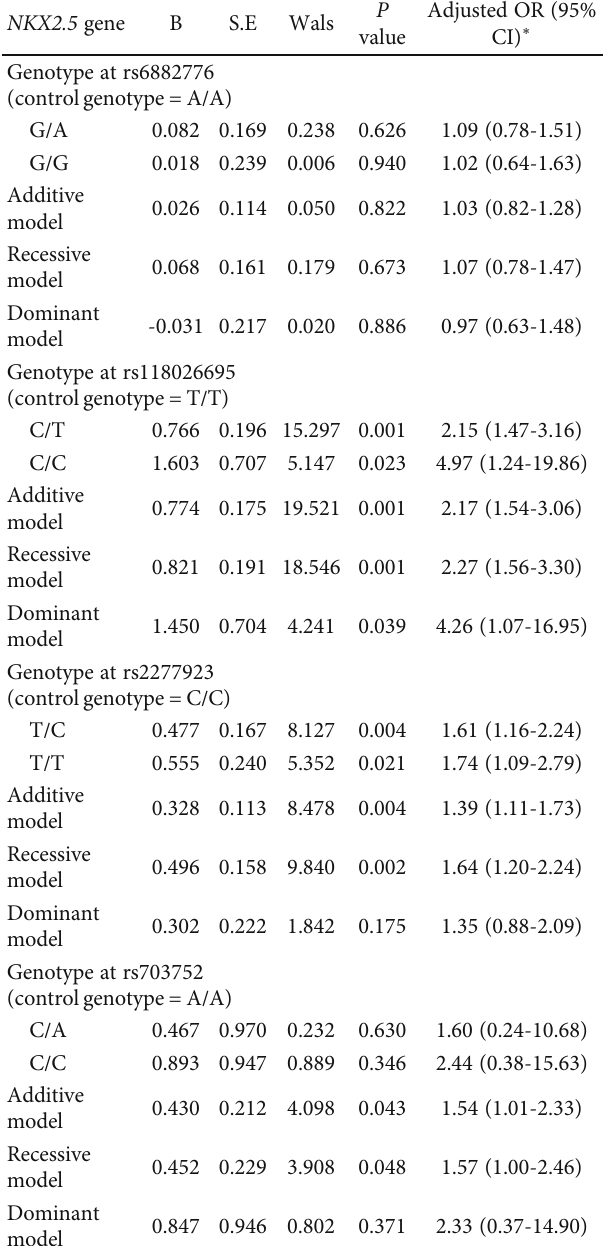
Table 5: Multivariate analysis of NKX2.5 gene polymorphism and